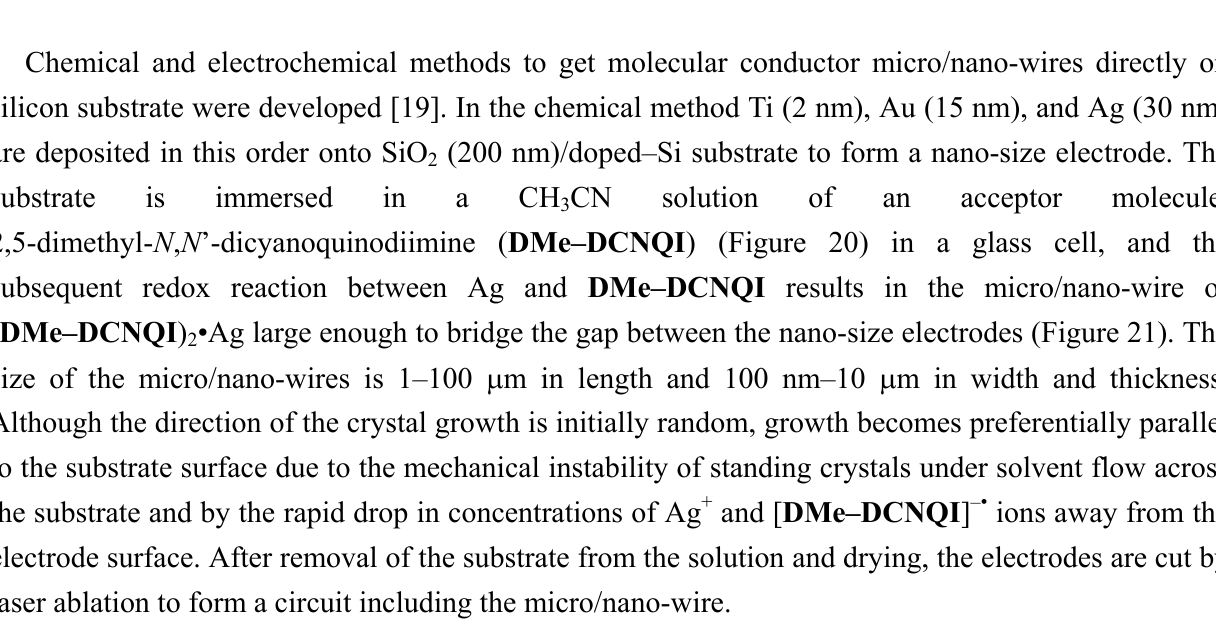
Figure 20. The chemical structures of 2,5-dimethyl- N , N’